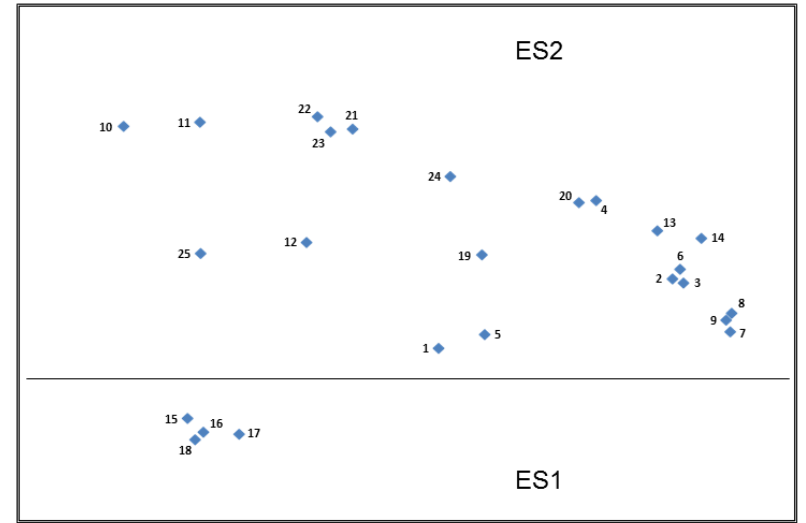
Figure 6. MSA Top Plot—Spain (ES). See Table 2 for the claims associated with the stimuli card